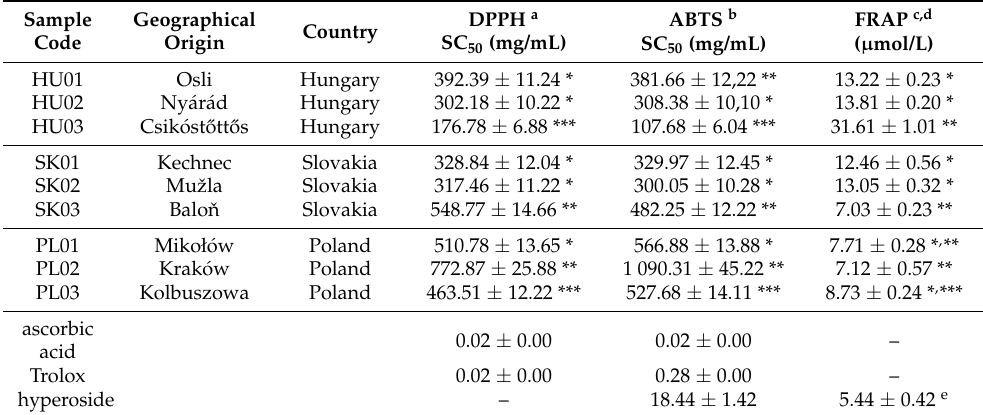
Table 3. Antioxidant activity of Hungarian-, Slovak-, and Polish-origin goldenrod honey. Sample